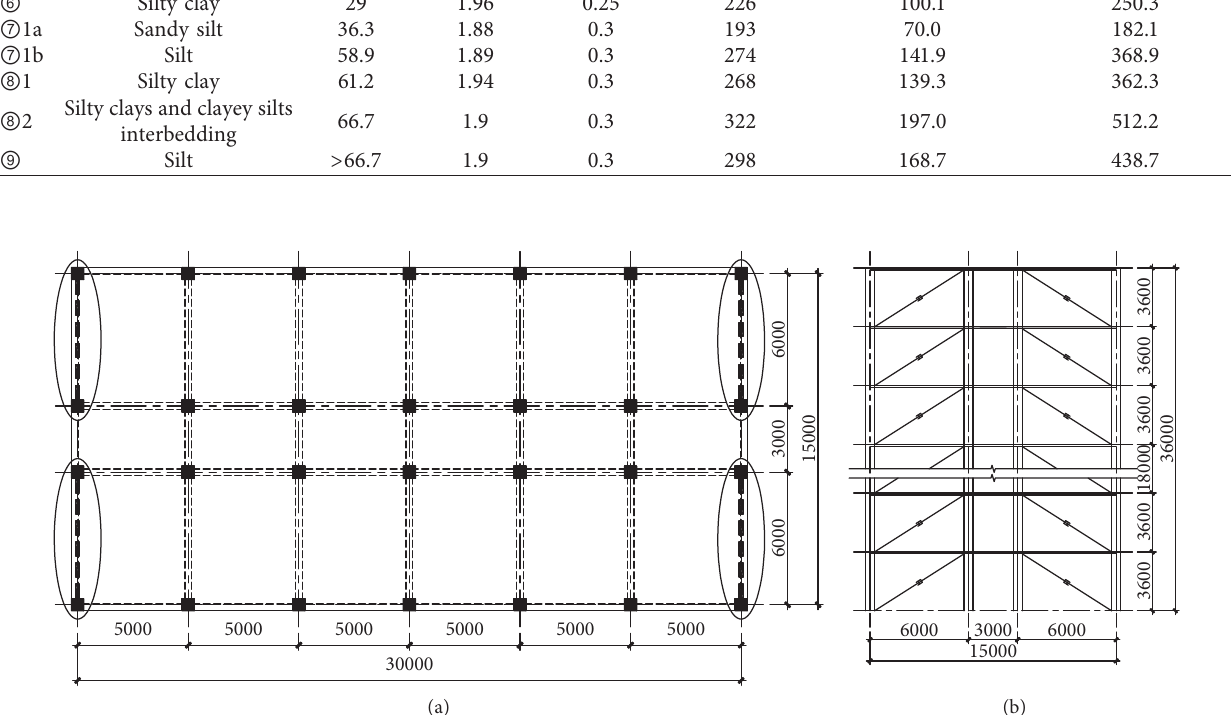
Figure 2: Arrangement of viscous dampers in: (a) plane and (b) elevation (unit: